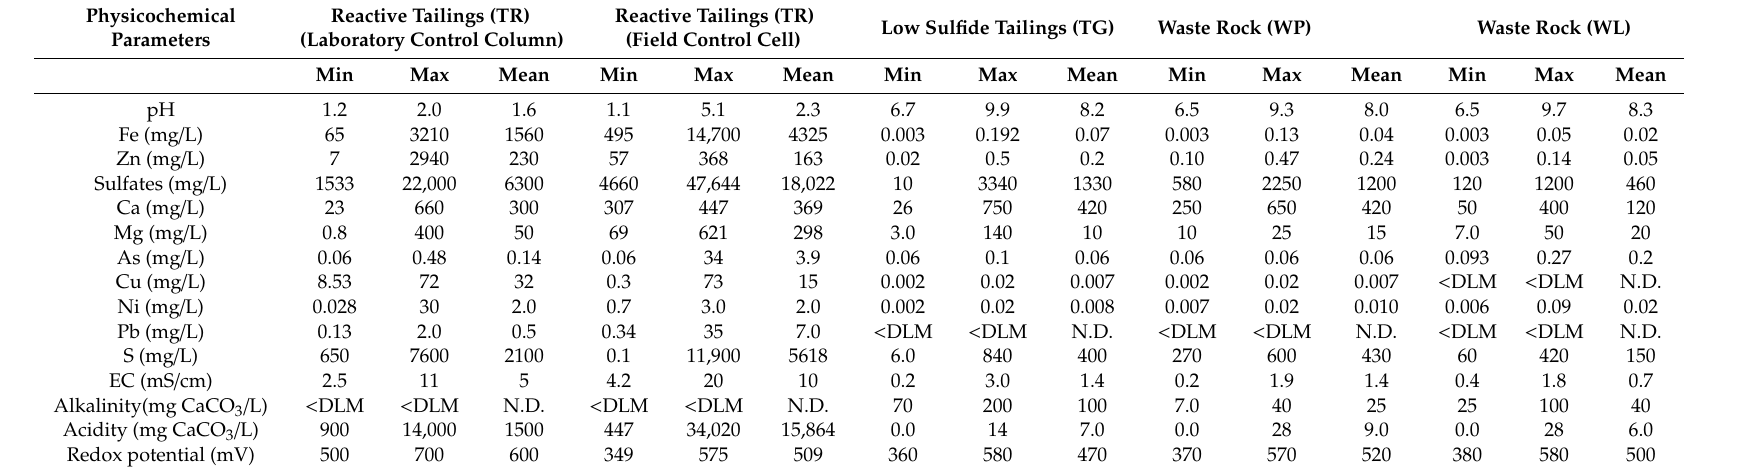
Table 4. Summary of the water quality results from reactive tailings and cover